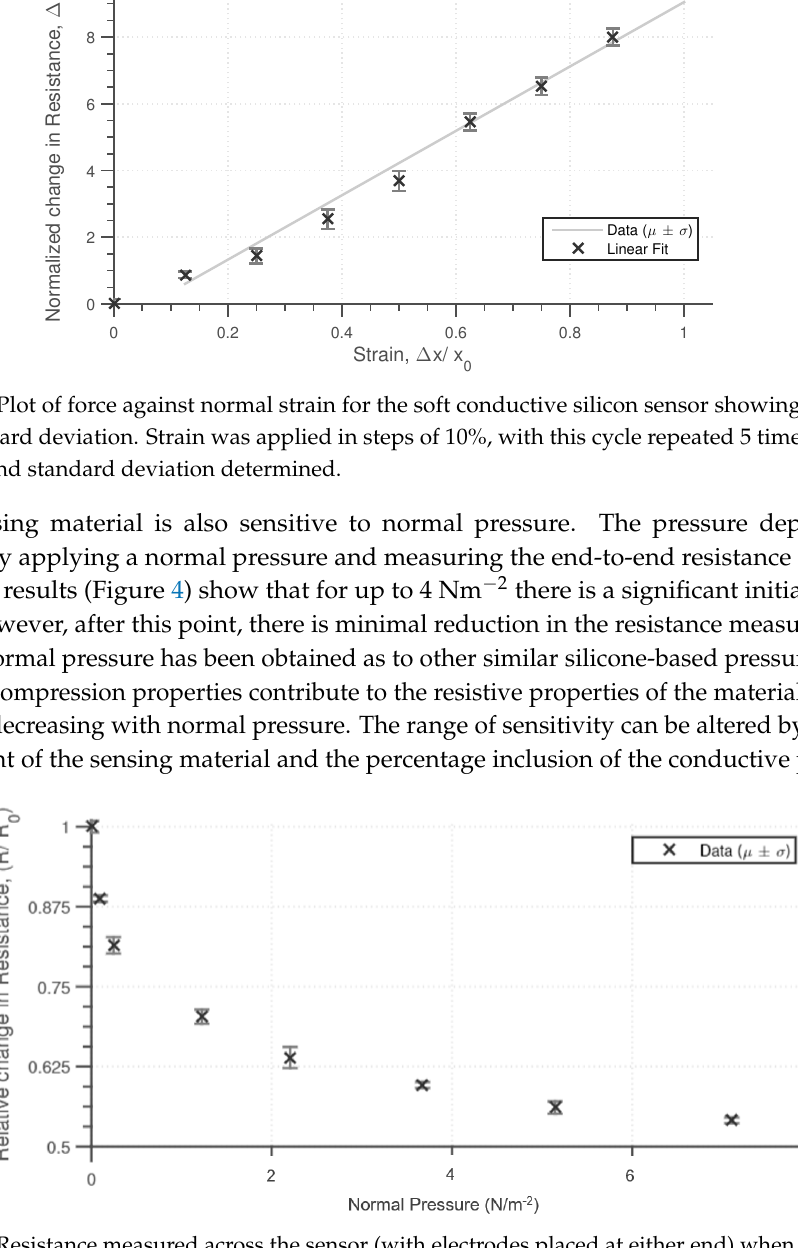
Figure 4. Resistance measured across the sensor (with electrodes placed at either end) when increasing loads (of base diameter 2 cm) are applied to the sensor. The experiment was repeated 5 times with the average and standard deviation